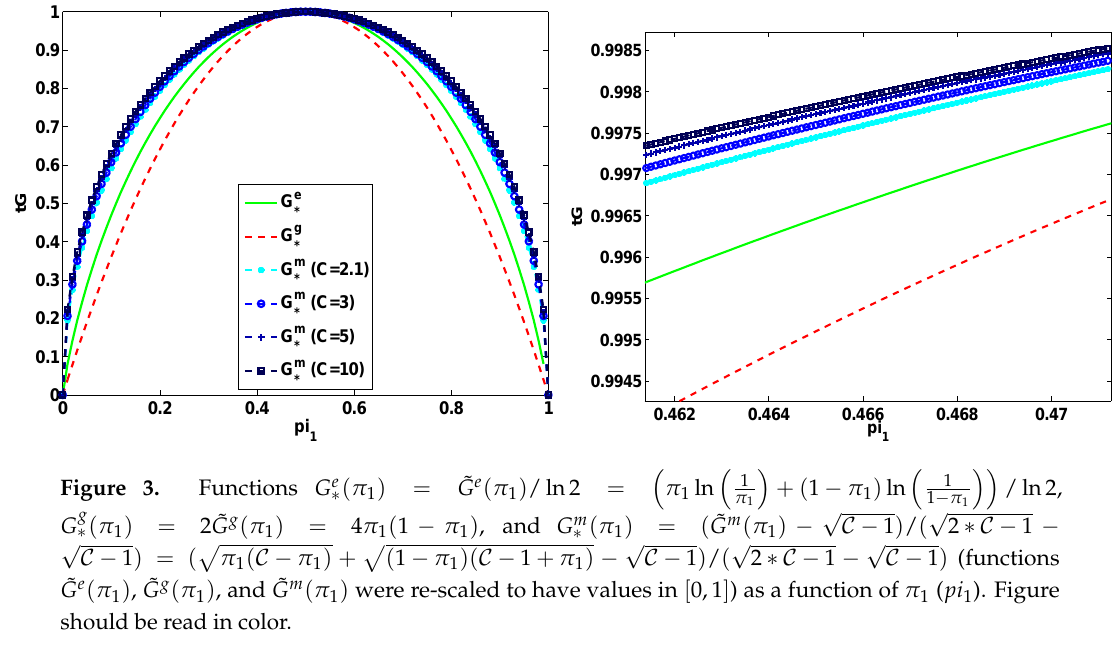
Figure 3. Functions G e ∗ ( π 1 ) = ˜ G e ( π 1 ) / ln2 =